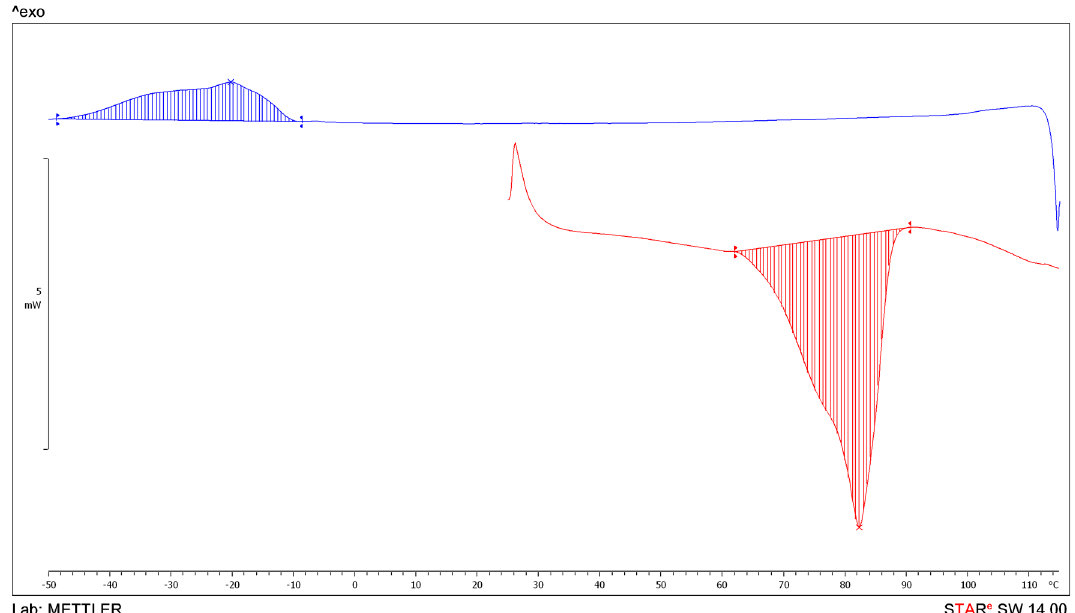
Figure 2. DSC-thermogram of a plasticizer of BEPEA. Figure 2 . DSC-thermogram of a plasticizer of BEPEA .